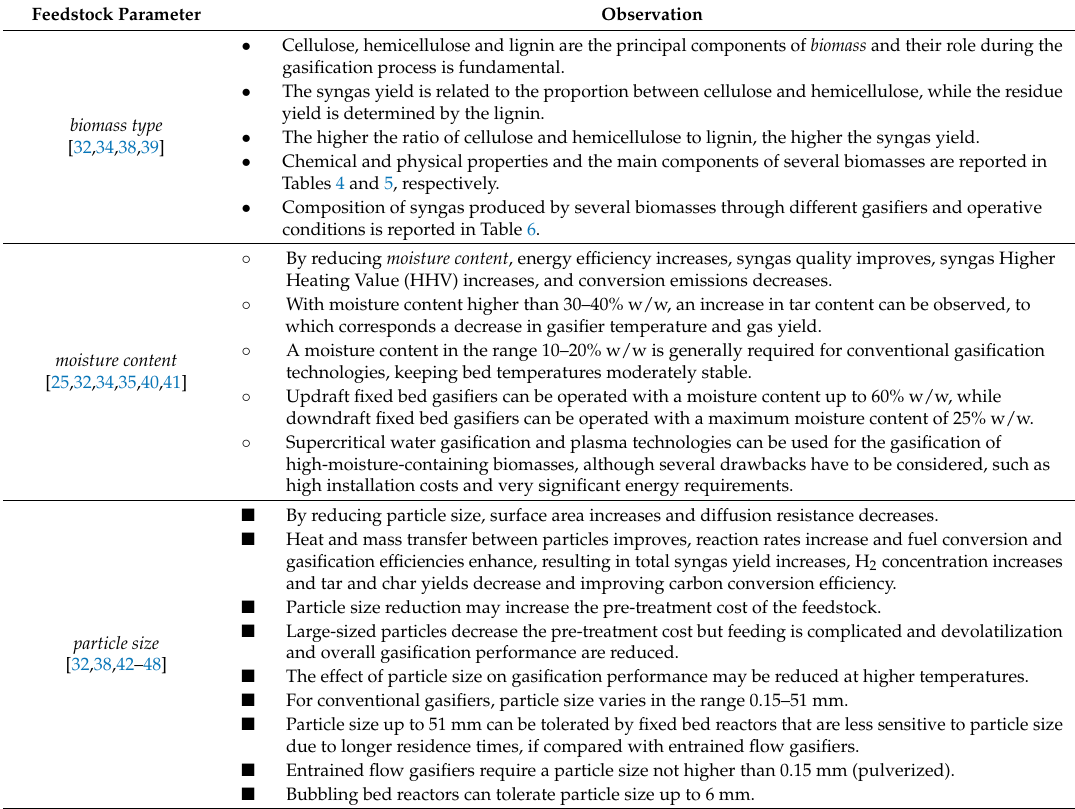
Table 2. Effect of feedstock characteristics on gasification process